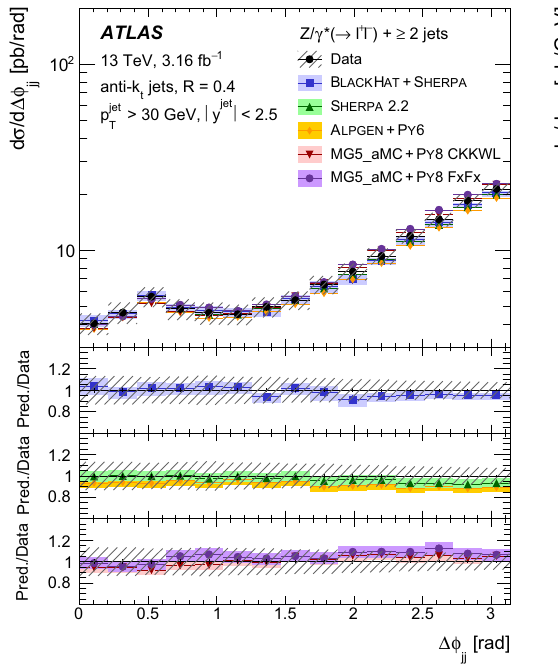
Fig. 8 Measured cross section as a function of (cid:4)φ jj ( left ) and m jj ( right ) for inclusive Z + ≥ 2 jet events. The data are compared to the predictions from BlackHat+Sherpa , Sherpa 2.2 , Alpgen+Py6 , MG5_aMC+ Py8 CKKWL, and MG5_aMC+ Py8 FxFx. The error bars